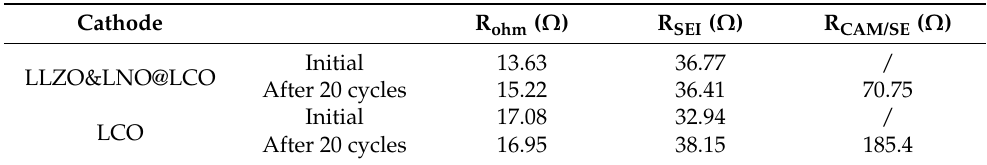
Figure 7. EIS curve of LCO||LPSC||Li-In and LLZO&LNO@LCO||LPSC||Li-In before ( A ) and after 20 cycles ( B ). Table 3. Impedance parameters of LCO||LPSC||Li-In and LLZO&LNO@LCO||LPSC||Li-In before (A) and after 20 cycles (B).